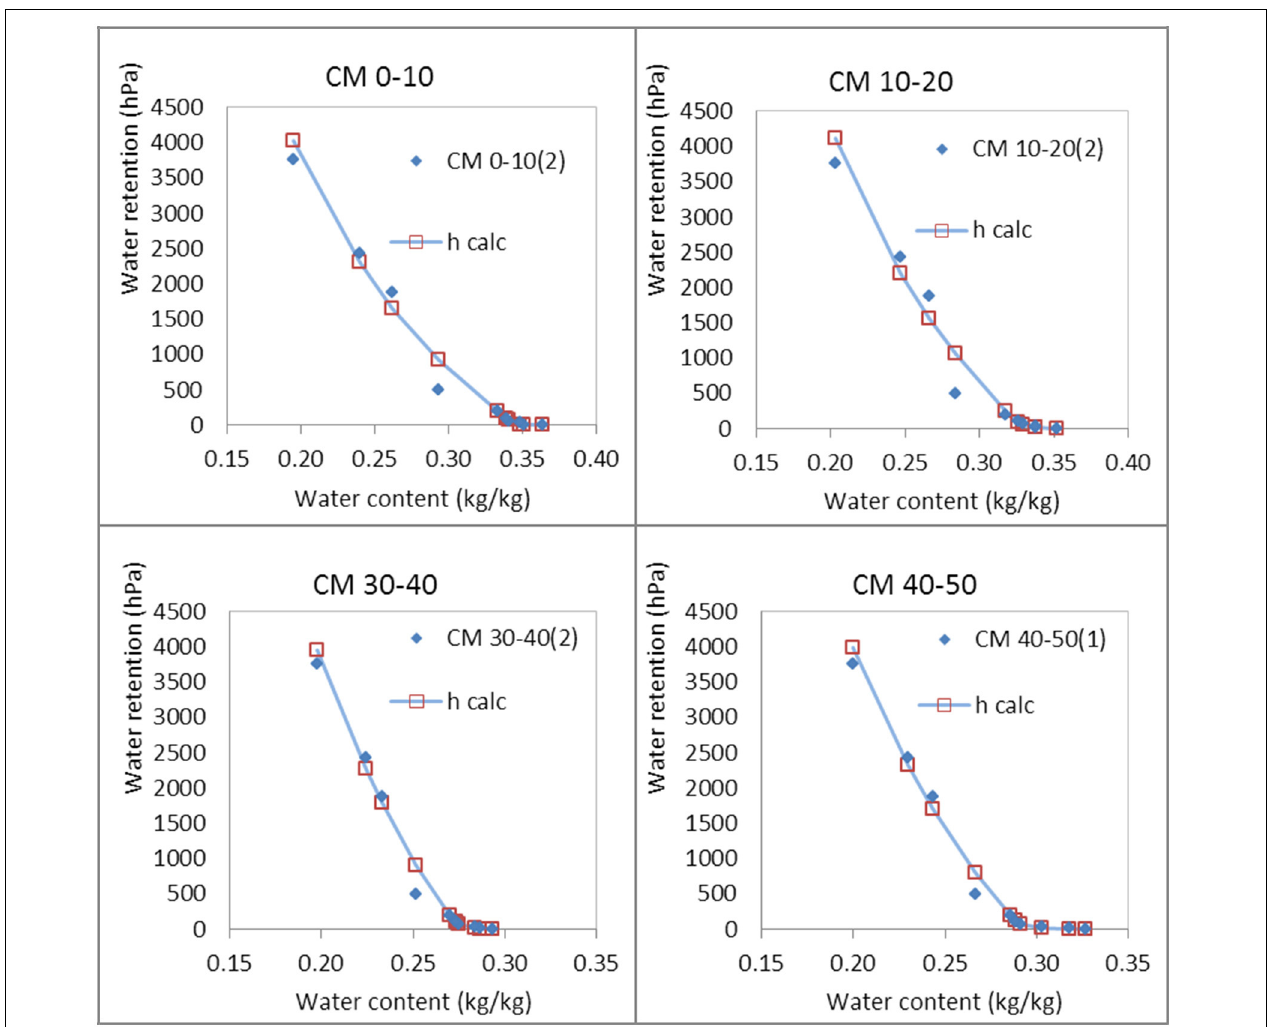
FIGURE 3 | Pedostructural water retention curves of the four first depth levels of the Chimney Meadow (Church Field) soil, measured (blue points) and fitted with the theoretical equation (blue line and red